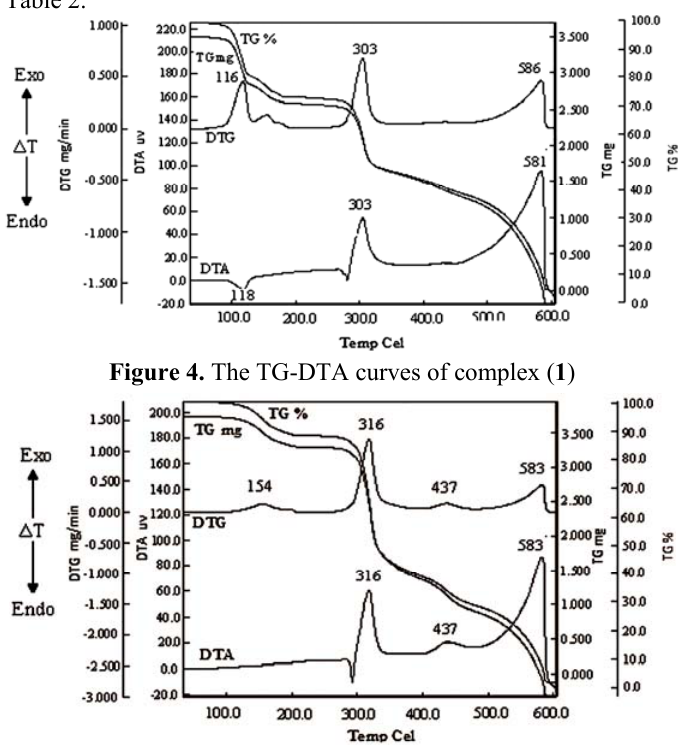
Figure 5. The TG-DTA curves of complex ( 2